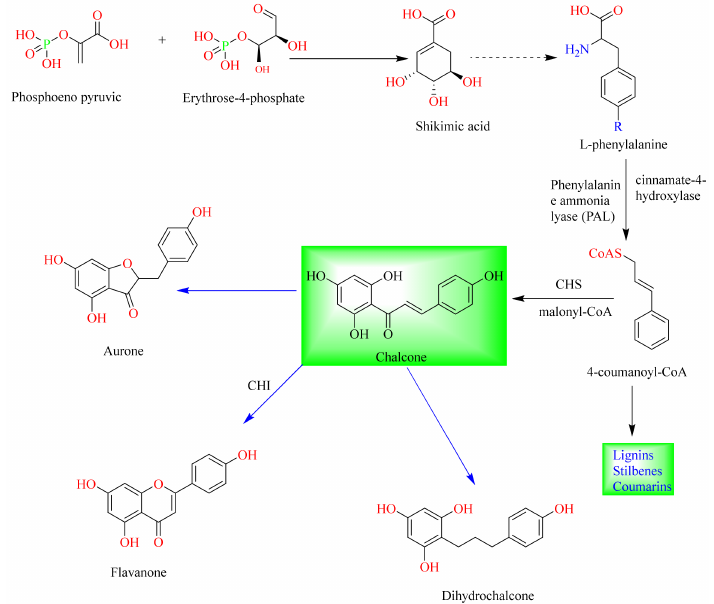
Figure 1. General biosynthetic pathway of flavonoids.